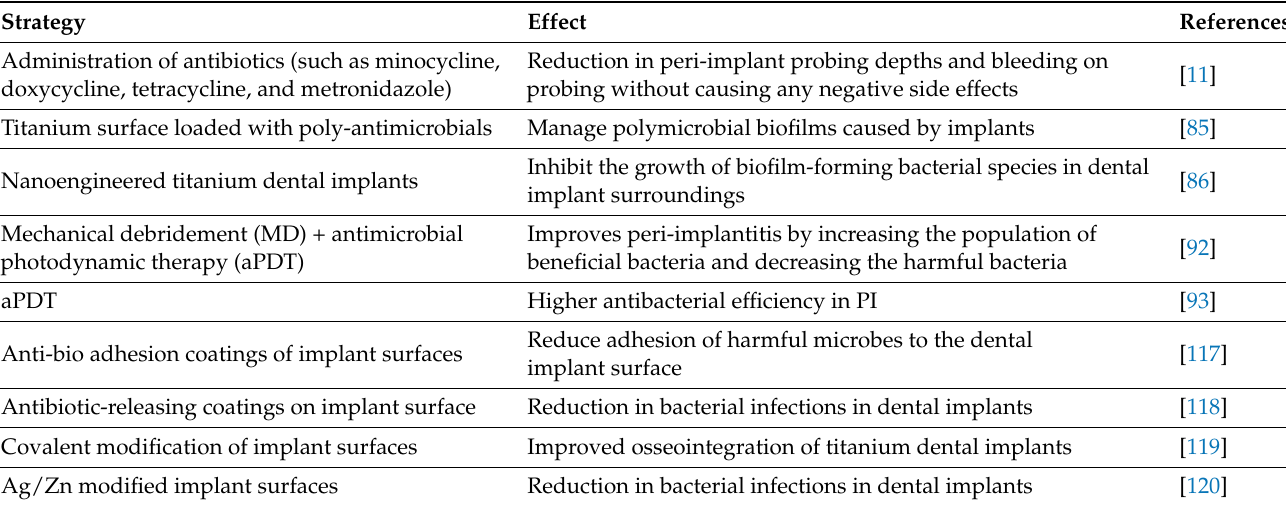
Table 1. Management strategies to control